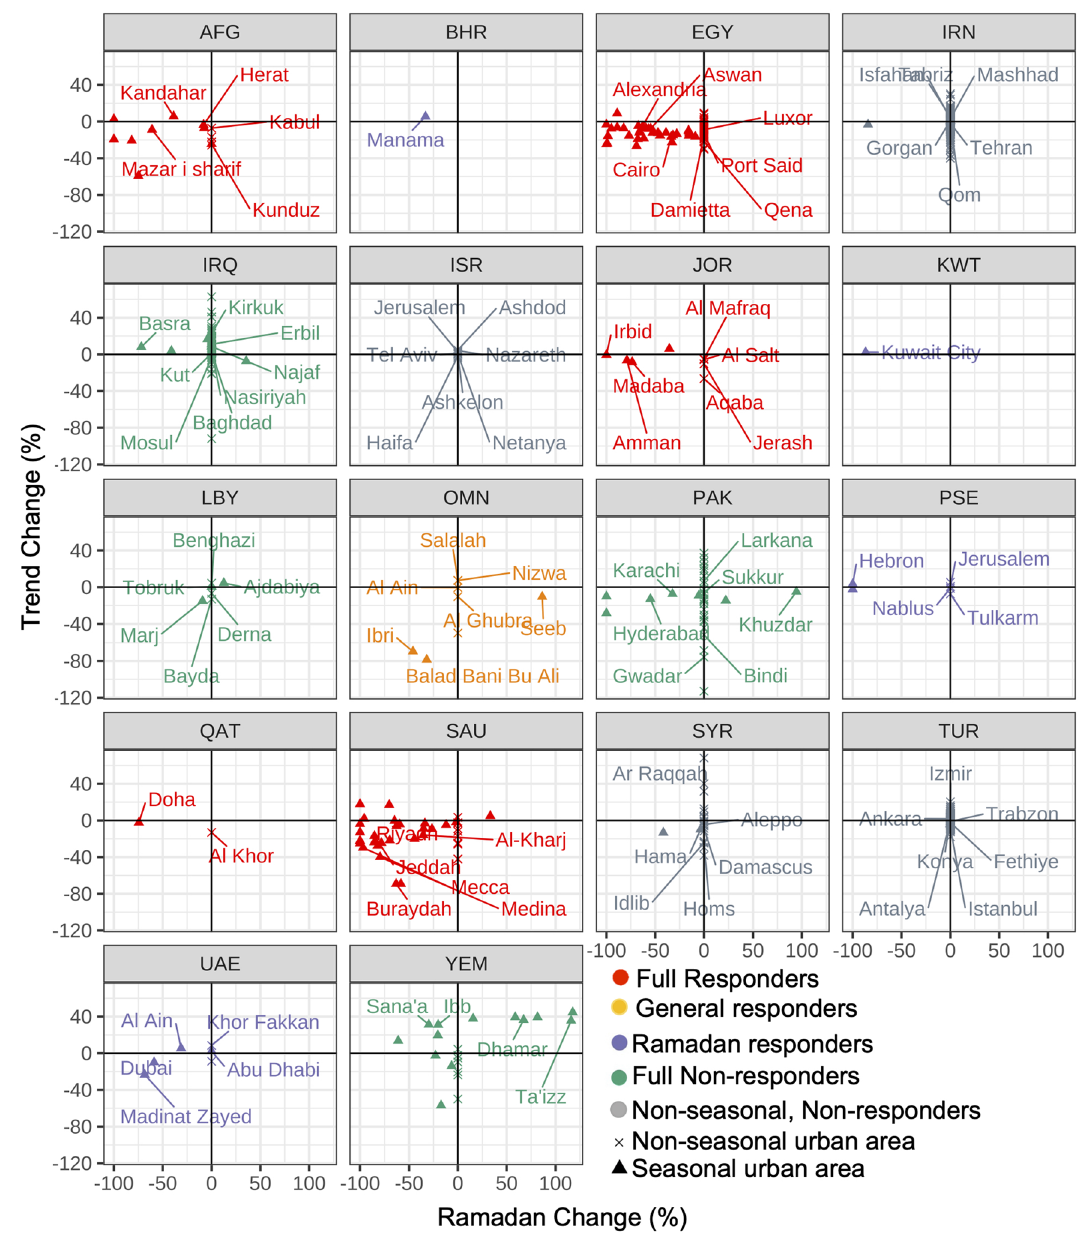
Figure 6. Percent change in Ramadan (seasonal) radiance is shown on the x-axis, while percent change in radiance generally during the remaining COVID-19 period (trend) is shown on the y axis. Country-plots are colored by the dominant typology of constituent urban areas. Seasonal urban areas (those with a consistent Ramadan increase, are represented as triangles, while non-seasonal urban areas are represented as an x. Figure created using ggplot2 version 3.3.5 33